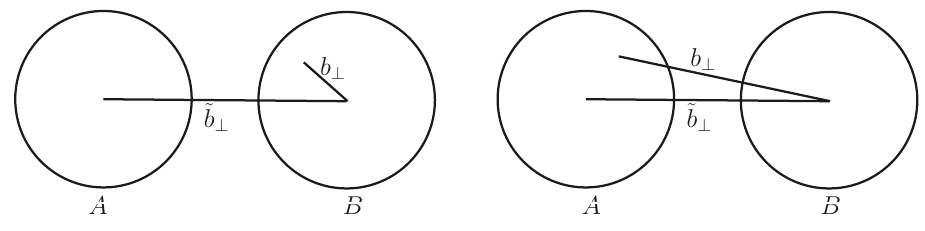
Figure 2 . The vector meson is locally produced in the transverse plane inside each nucleus(A or B) which takes turns to act as the target and the quasi-real photon source. This creates a set up of the Young’s double-slit experiment at fermi scale. To suppress hadronic interactions, ~ b ? must be larger than 2 R A